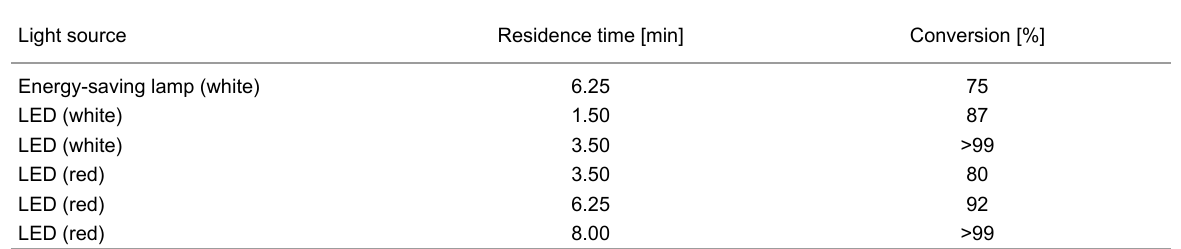
Table 3: Residence time and conversion with different light sources. a